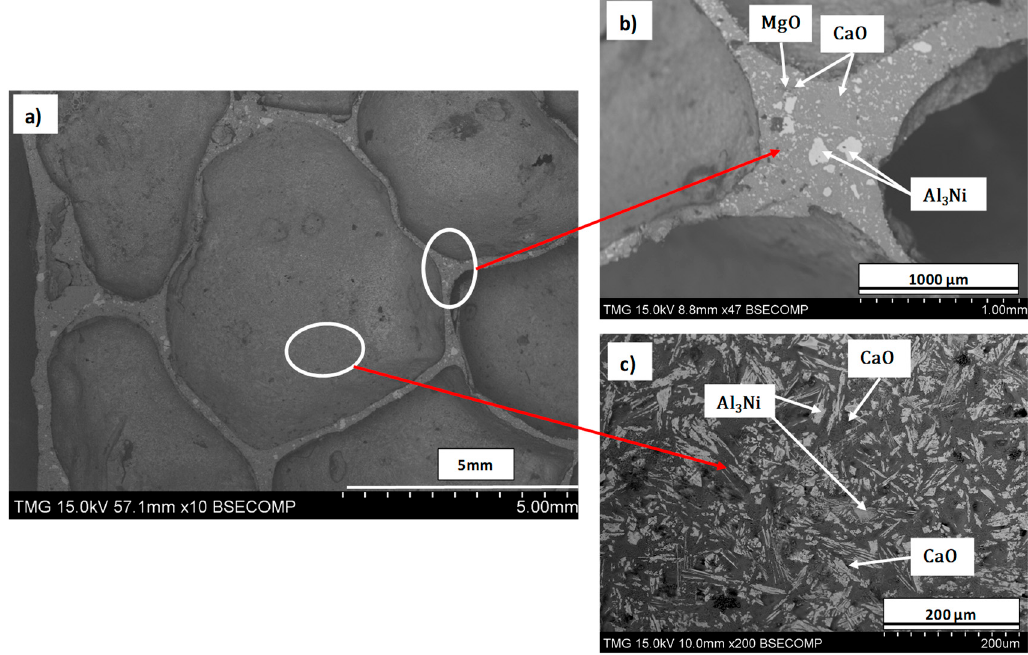
Figure 12. Compositional images of Al–10Ni foams with 7 wt.%: microstructure ( a ), plateau border ( b ), and internal cell surface ( c ).